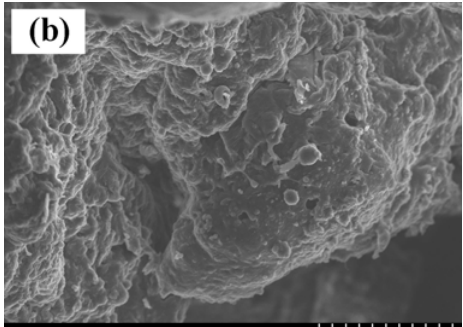
Figure 2. SEM micrograph of LLDPE produced with metallocene catalyst. (a) homopolymer (b) ethylene/1-hexene copolymer ( c) ethylene/1-octadecene